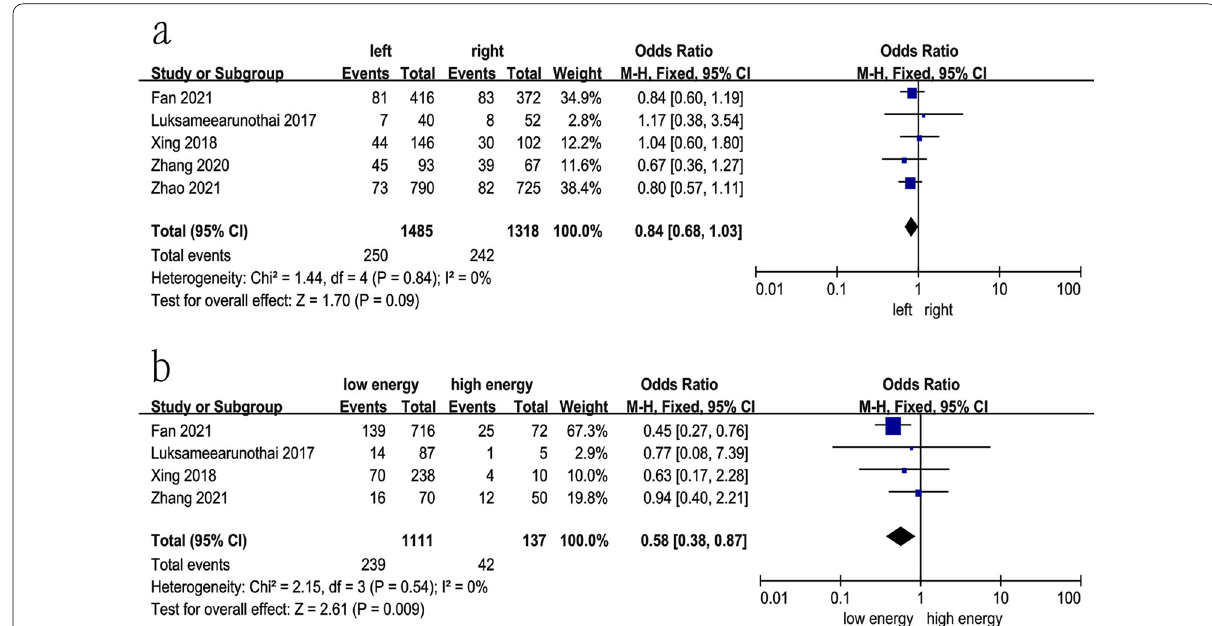
Fig. 13 Forest plot showing the relationship between injury side and mechanism and preoperative DVT in 2 groups. CI confidence interval, df degrees of freedom, M-H Mantel–Haenszel. a Injury side; b injury